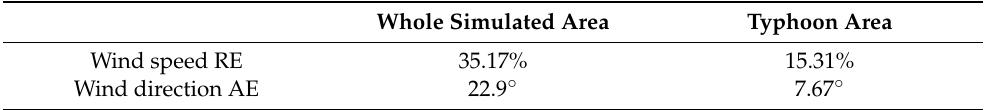
Table 4. The wind-tracking errors of the whole simulated area and typhoon central area at 400 hPa, with revisiting time set to 5